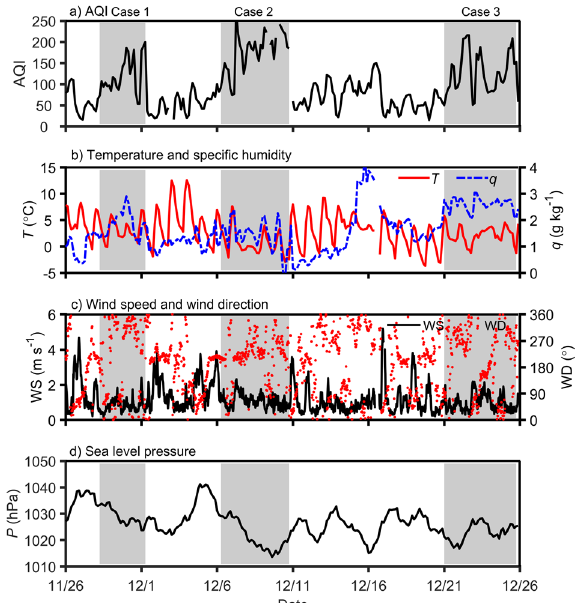
Fig. 2 Temporal variations of air quality and meteorological factors in the surface layer at Renqiu station during the observation period. a air quality index (AQI), ( b ) temperature ( T ) and speci fi c humidity ( q ), ( c ) wind speed (WS), and wind direction (WD), ( d ) sea level pressure ( P ). The shaded areas represent three haze